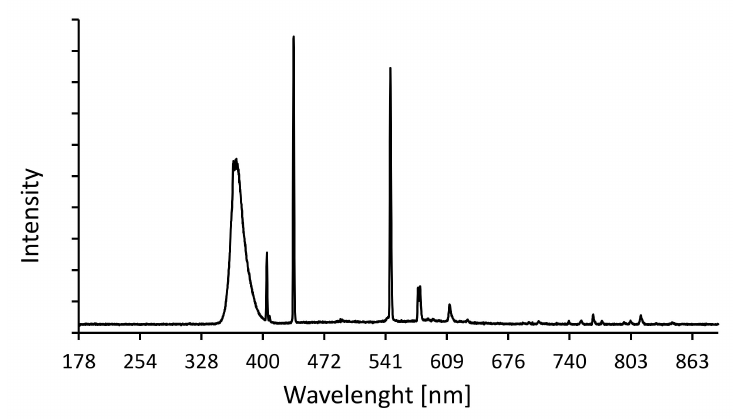
Figure 5. Emission spectra four UV lamps (4 × 22W, Philips) with the cumulative radiation intensity of 100 W / m 2 UV and 4 W / m 2